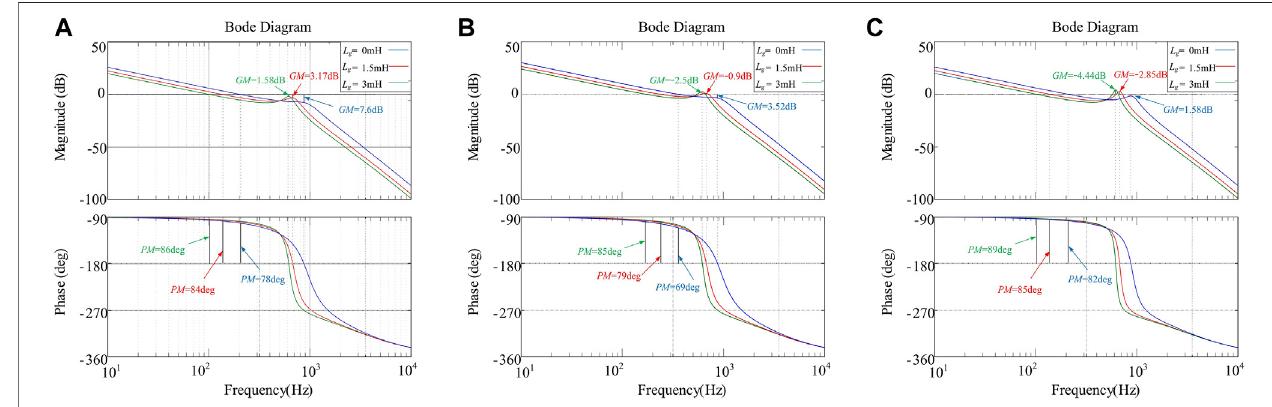
FIGURE 3 | Bode diagram of the system open-loop transfer function. (A ) K p (cid:1) 0.025, k ad (cid:1) 2 × 10 – 9 . (B) K p (cid:1) 0.04, k ad (cid:1) 2 × 10 – 9 . (C) K p (cid:1) 0.025, k ad (cid:1) 1 × 10 – 9 .